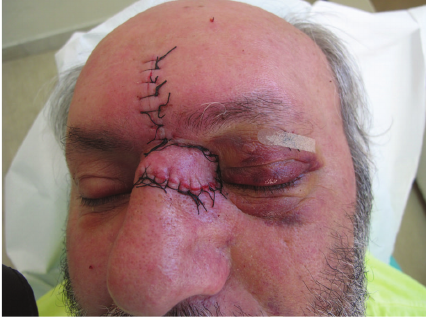
Figure 2: Reconstruction with glabellar flap.